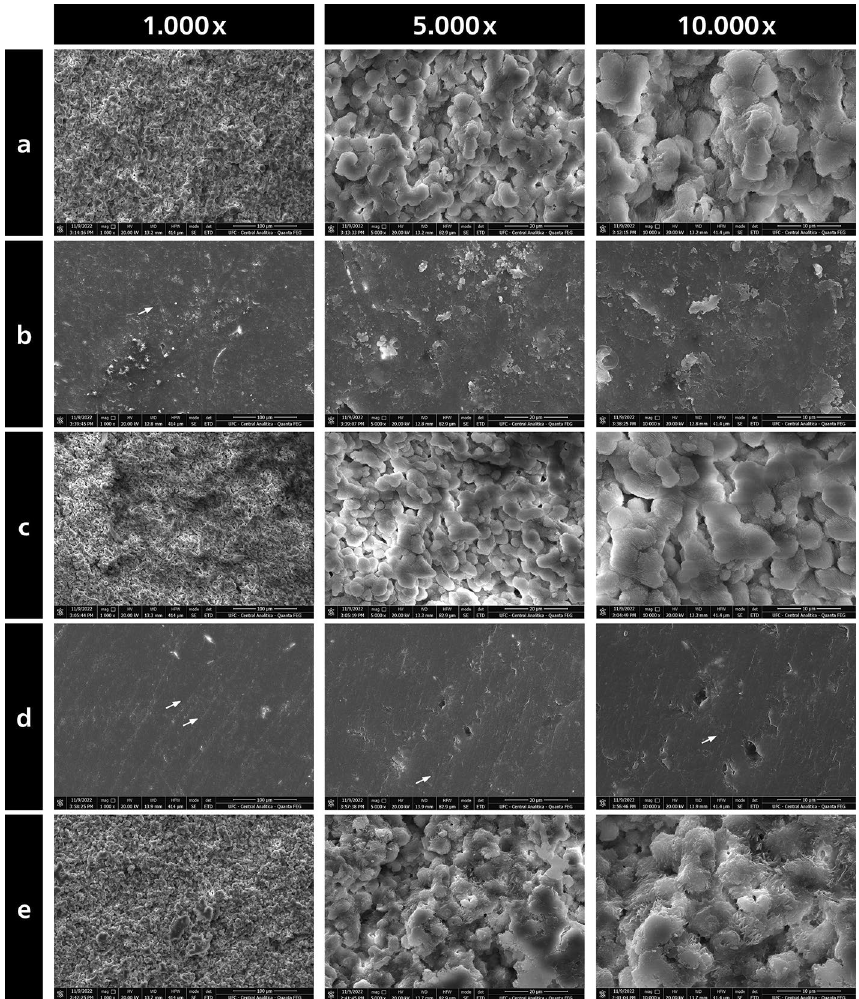
Figure 6. Representative scanning electron microscopy images of the enamel surfaces after the different polishing protocols and after 14 days in situ (Magnifications: 1.000 X, 5.000 X, 10.000 X). White arrows indicate groves, valleys and scratches on the enamel surfaces caused by the polishing procedures, which were still present after the intraoral caries challenge. Moreover, the group polished with Al 2 O 3 -disks showed the least amount of biofilm still present over enamel surface, which relates well to the previous results in which this group also showed the least amount of total bacterial counts, the lowest surface roughness, and the lowest